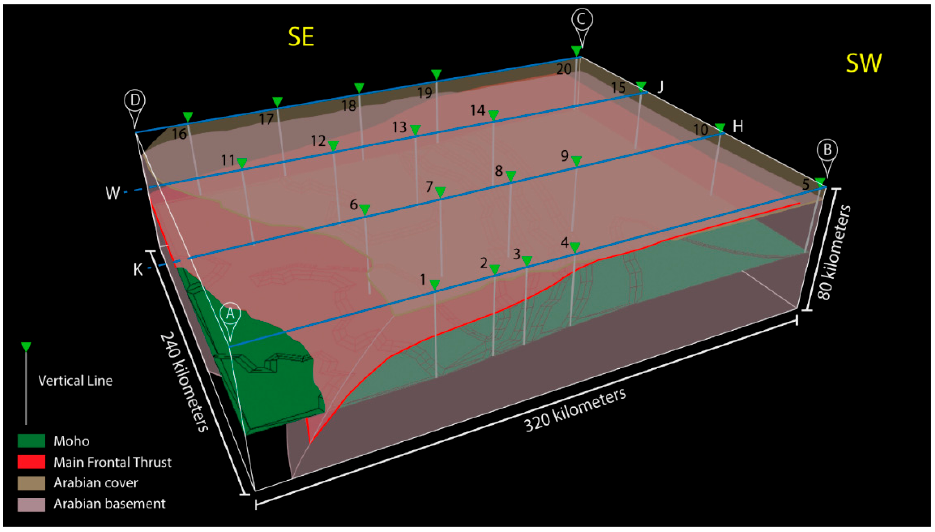
Figure 5. The 3-D geological model with the location of pseudo-wells (grey vertical lines numbered 1 to 20) and section traces (blue lines, AB, KH, WJ, DC) used to perform the analytical procedure.